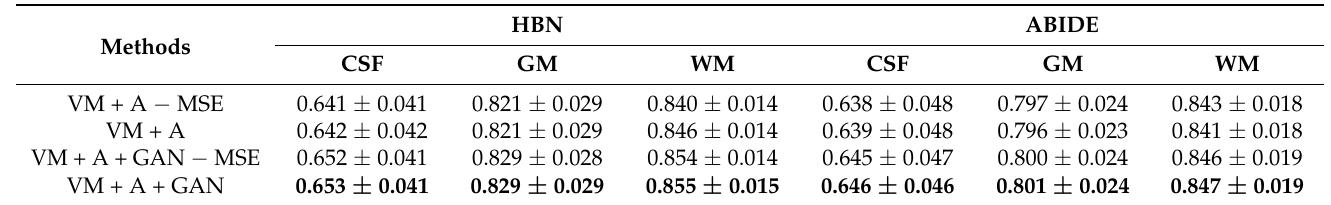
Table 5. Dice values when using the MSE loss function and the HBN and ABIDE datasets. Bold numbers indicate the best results.